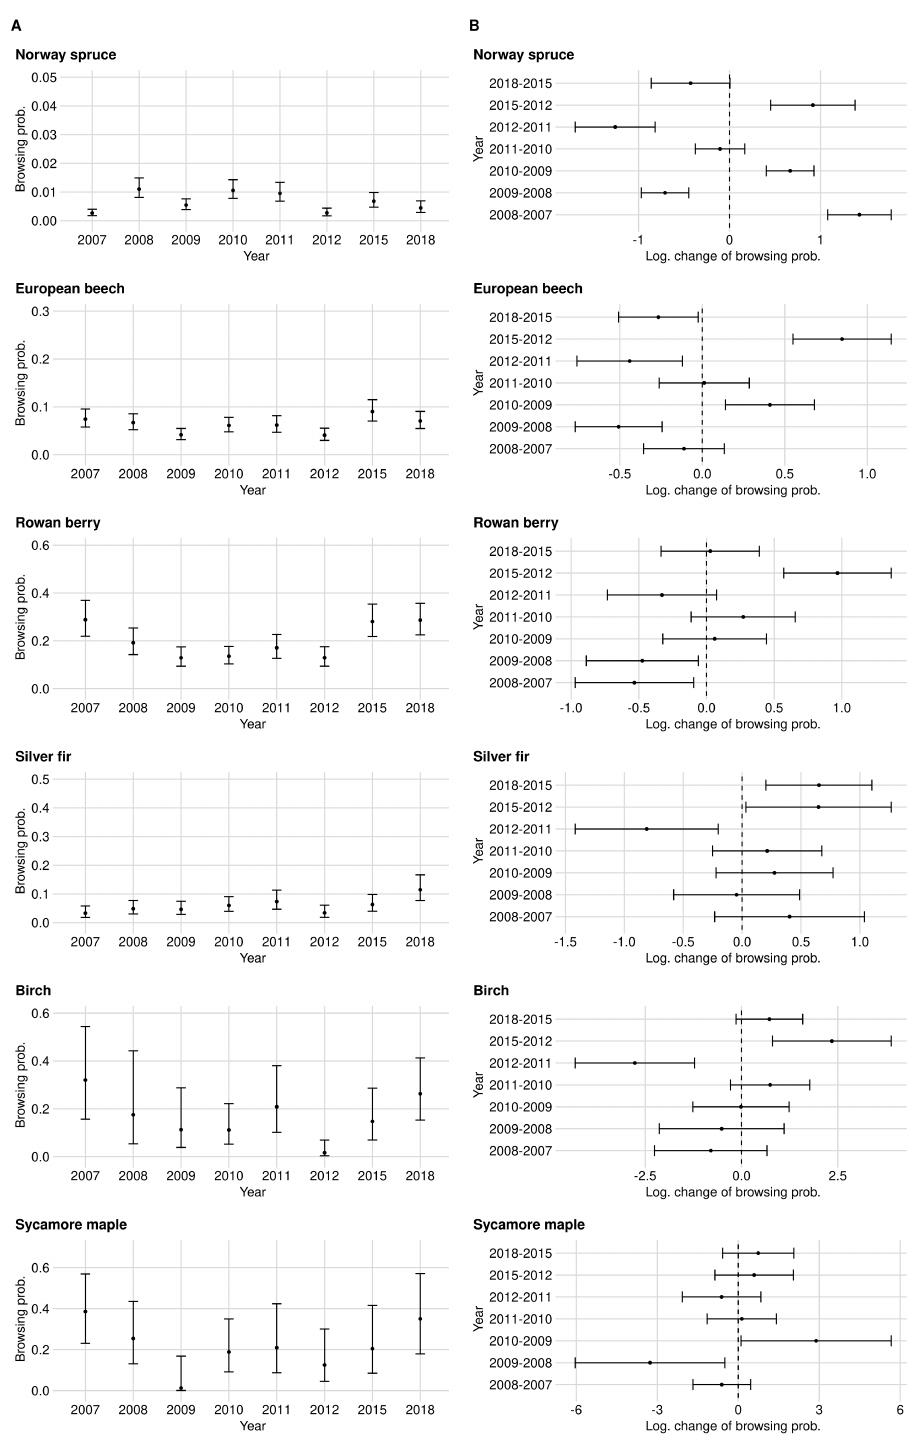
Figure A6. Time series and confidence intervals of the BP ( A ) and the corresponding logarithmic change of the BP between two consecutive acquisition years ( B ). The estimated logarithmic change of BP (black point inside the confidence intervals) is positive if BP increased compared to the previous year, and is negative if it decreased. If either the upper or the lower end of the confidence intervals completely crossed the zero on the x-axis, the change of the BP is not significant. The estimates are related to the RLG data